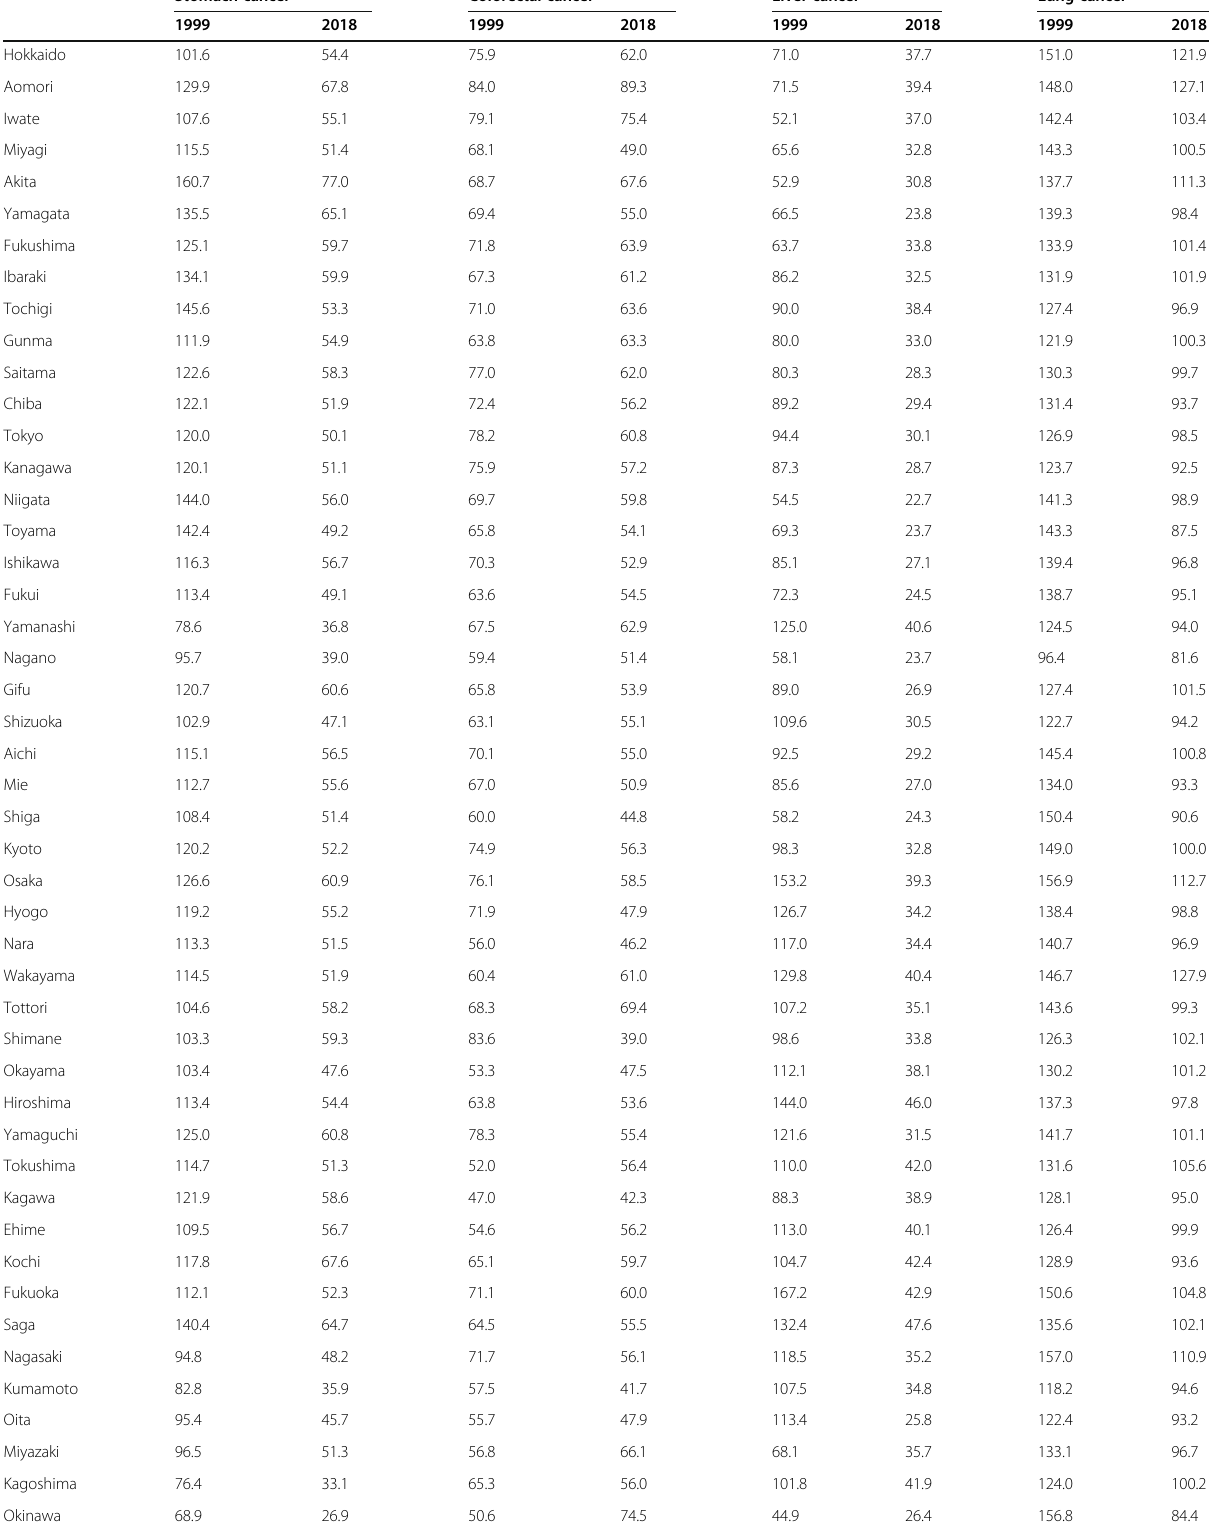
Table 1 Age-standardized mortality rates for each type of cancer in 1999 and 2018 among men Stomach